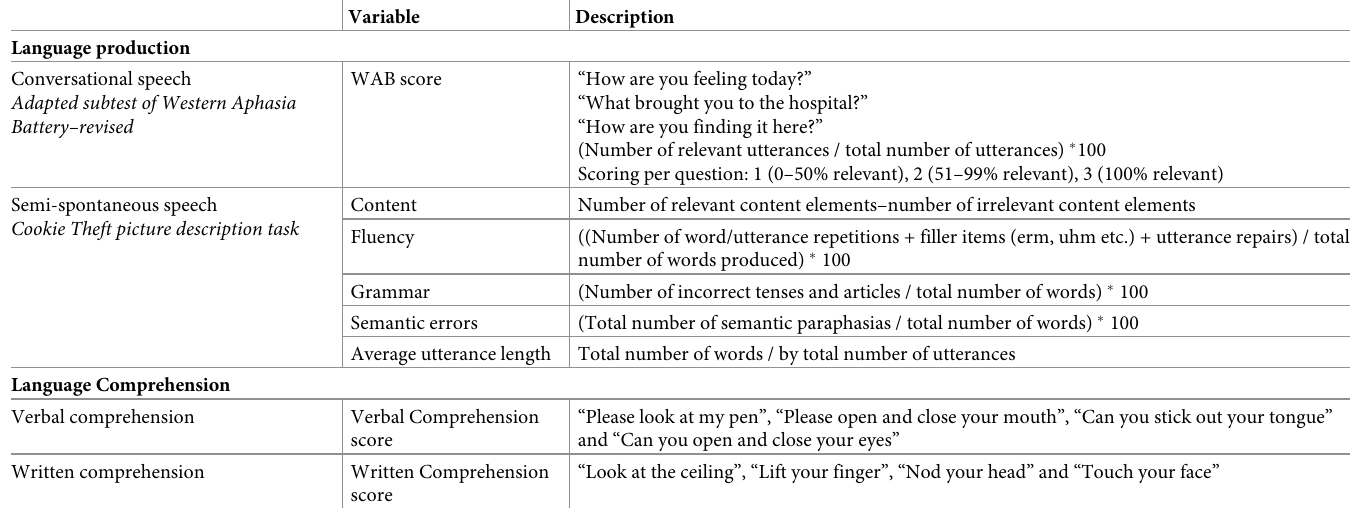
Table 2. Language assessment: Task variables derived from the conversational speech assessment and Cookie Theft picture